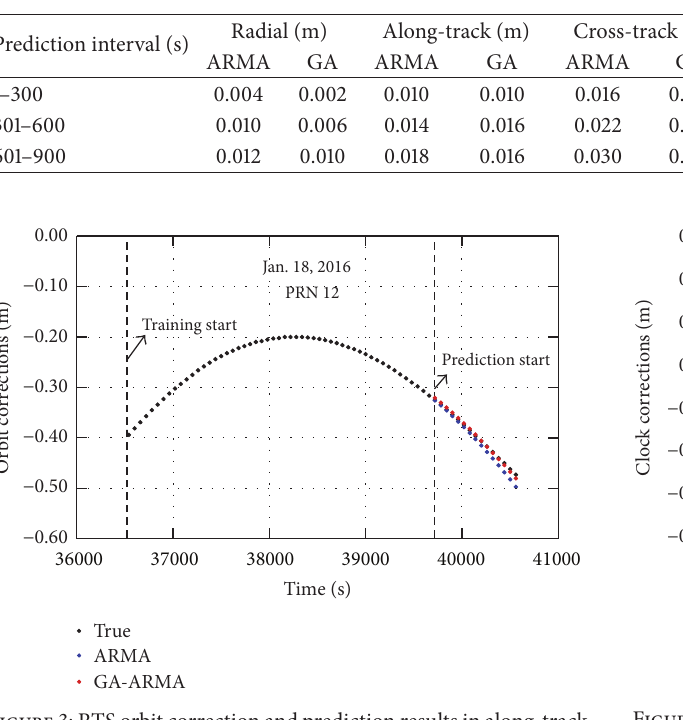
Figure 3: RTS orbit correction and prediction results in along-track direction (PRN 12, January 18, 2016).